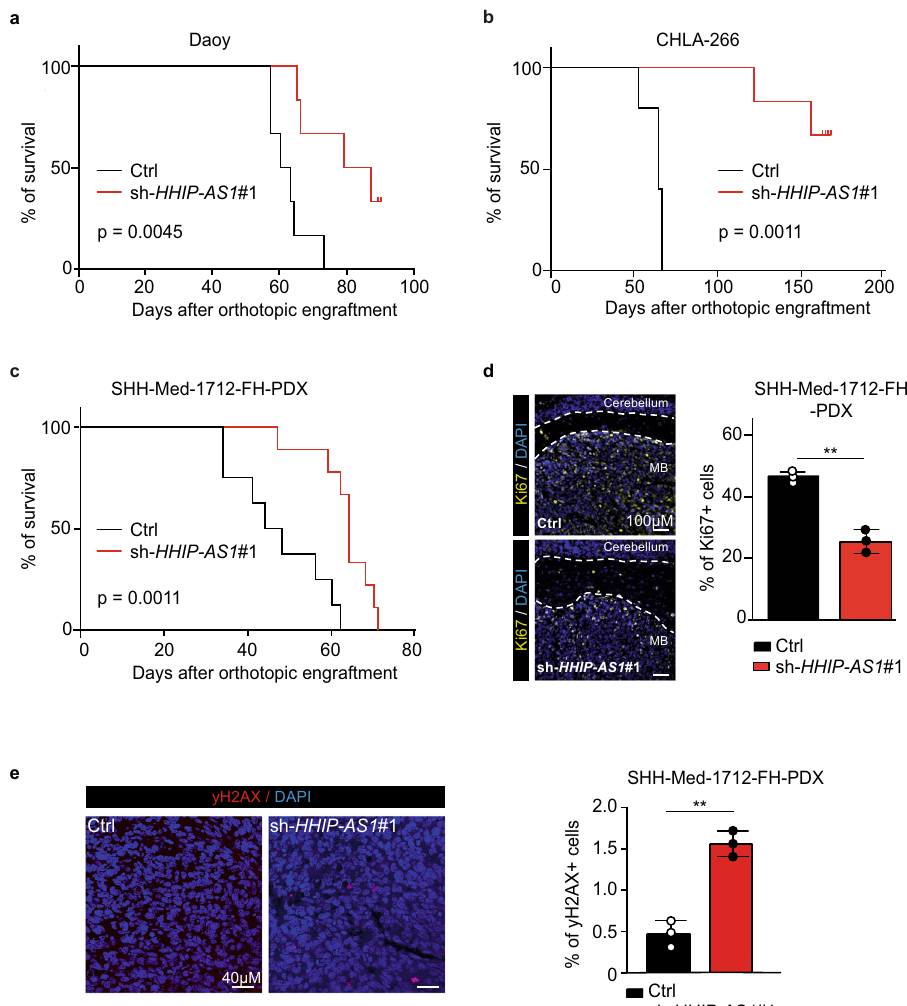
Fig. 6 Loss of HHIP-AS1 extends survival in SHH-driven brain tumor models in vivo. a , b Kaplan – Meier estimates of nude mice orthotopically engrafted with stably HHIP-AS1 -silenced (sh- HHIP-AS1 #1) Daoy ( a , n = 13 mice) and CHLA-266 ( b , n = 13 mice) cells compared to corresponding controls (sh- scr ), respectively. c Survival curves of nude mice orthotopically engrafted with transiently HHIP-AS1 -silenced (sh- HHIP-AS1 #1) SHH-Med-1712-FH cells ( n = 17mice). For panels a , b , and c , the median survivals were compared using Mantel – Cox test. d,e Three controls and three HHIP-AS1 -depleted SHH- Med-1712-FH tumors were immunostained for Ki67 (yellow, d , white scale bar: 100 µ m), γ H2AX (red, e , white scale bar: 40 µ m) and the percentage of positive stained tumor cells is plotted in the bar graphs as mean ± SD. Nuclei are stained with DAPI (blue). Both, control (ctrl = sh- scr ) and sh- HHIP-AS1 #1 tumor tissue, are shown in the two representative images. Student ’ s two-sided t -test, ** p < 0.01. Source data and exact p -values are provided as a “ Source Data fi le ”